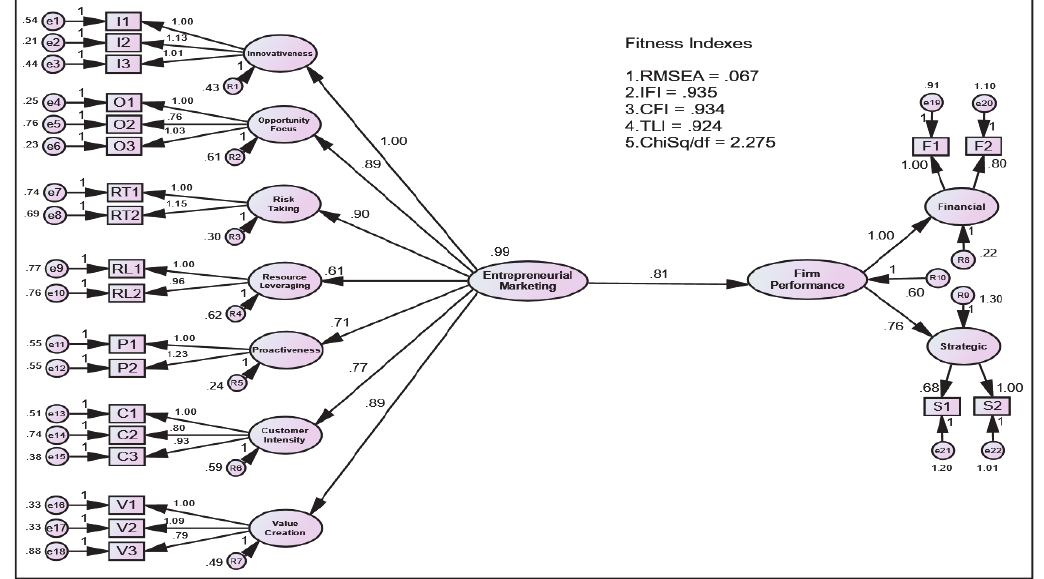
Fig. 3. Unstandardized Regression Path Coefficient for the